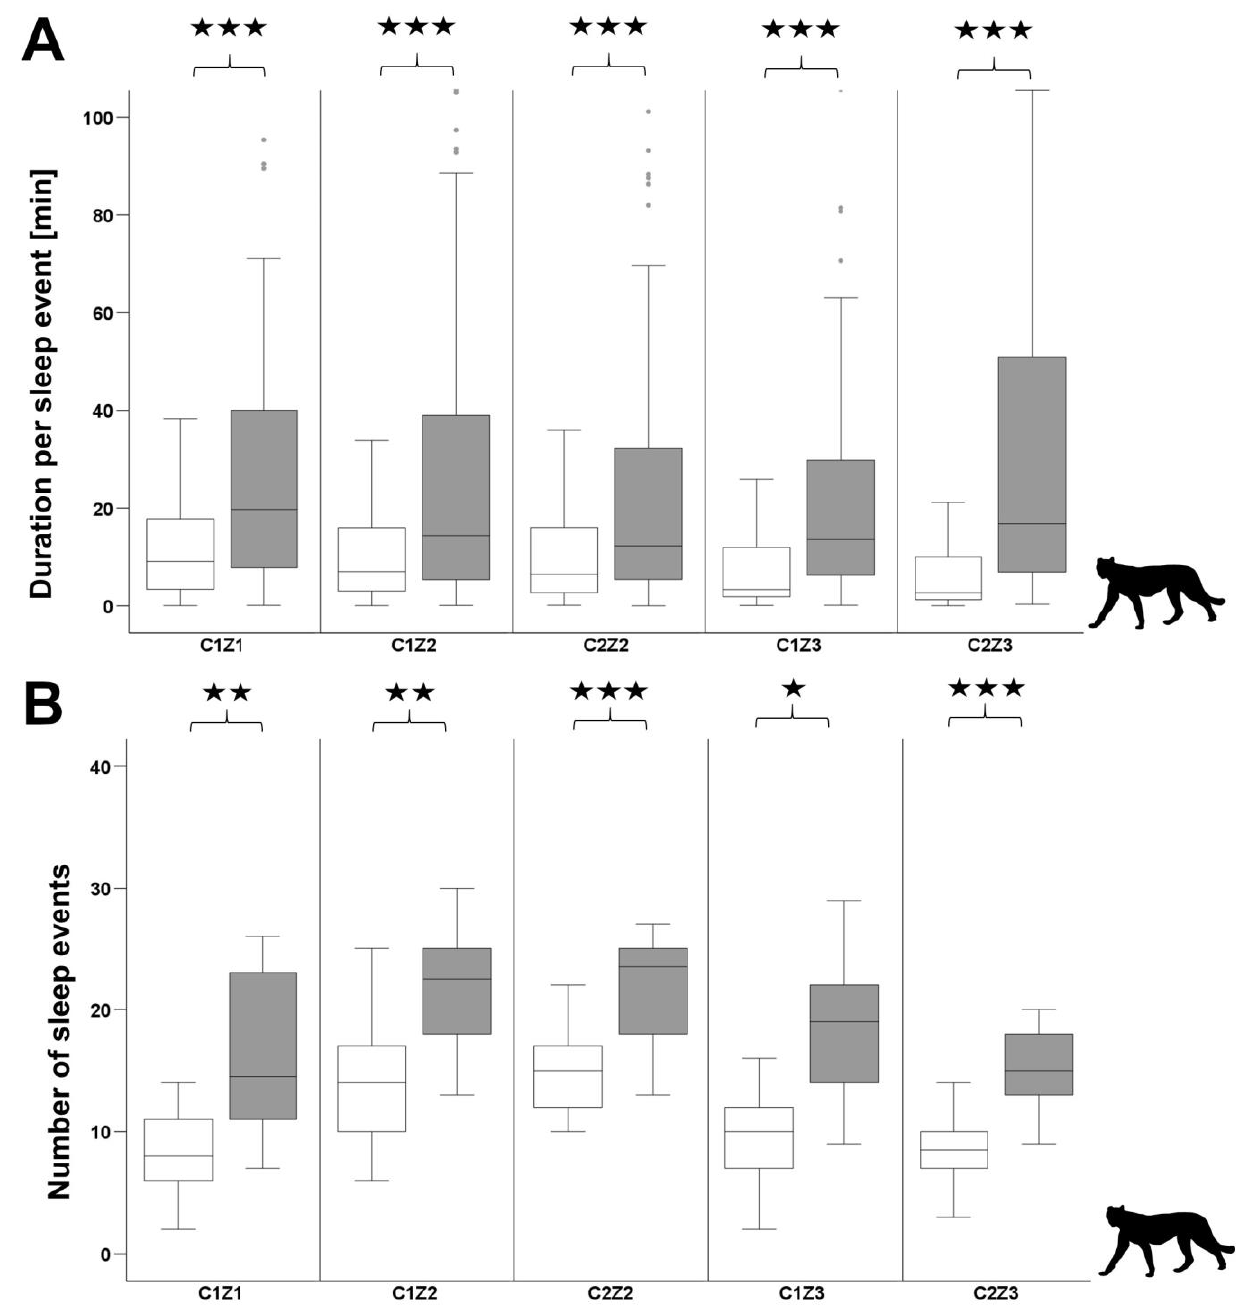
Figure 4. Diurnal (7 a.m.–7 p.m.) and nocturnal (7 p.m.–7 a.m.) sleep patterns of cheetahs. ( A ) Duration per sleep event and ( B ) Number of sleep events per day (white boxes) and per night (grey boxes); n.s. > 0.05; * p < 0.05; ** p < 0.01; *** p < 0.001) over the total observation period. Between both species, the daily duration per sleep event ( t -test: T = 14.79, p < 0.001, df = 27) and the nocturnal duration per sleep event ( t -test: T = 9.79, p < 0.001, df = 27) differed significantly. Lions spent more time per sleep event than cheetahs, both during the day and the night (Table 3). With regard to the number of sleep events, there were significant differences between the two species during the day and the night. Compared to lions, cheetahs showed significantly more sleep events during the day ( t -test: T = 22.60, p < 0.001, df = 27) and the night ( t -test: T = 10.76, p < 0.001, df = 27).